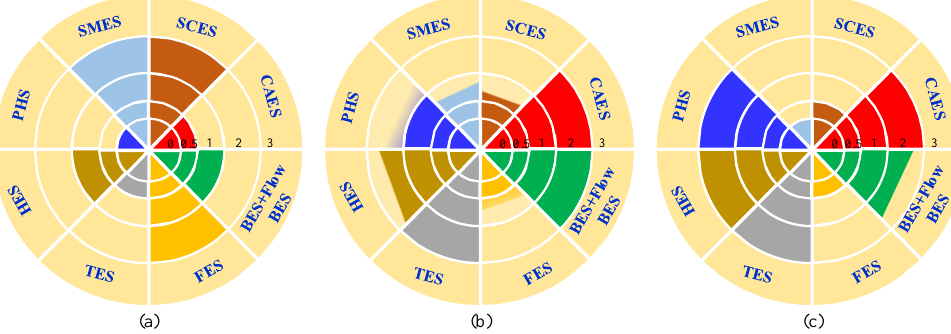
Figure 14. The ESSs ’ suitability for various applications. The appropriateness level ranges between 0 (least suited) and 3 (most suited): ( a ) applications relating to power quality; ( b ) applications of bridging power; and ( c ) applications for energy management.